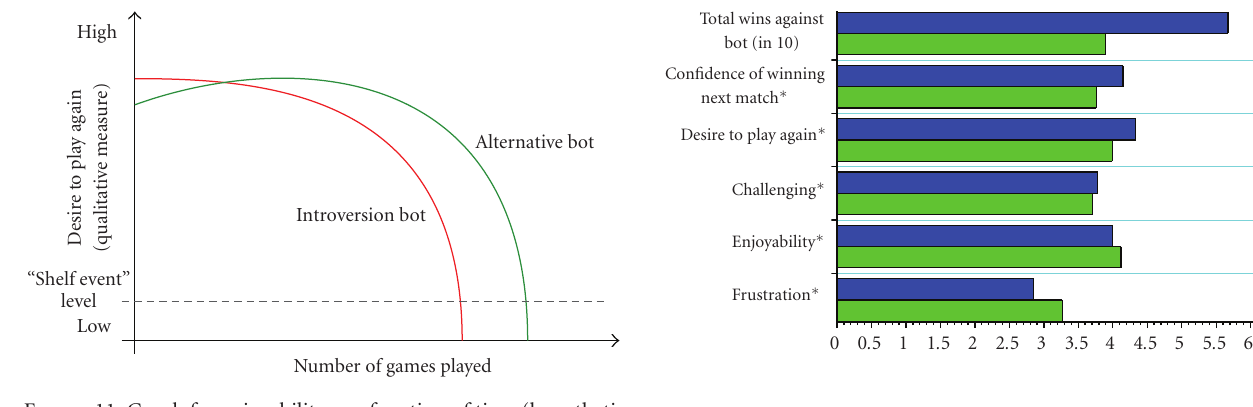
Figure 11: Graph for enjoyability as a function of time (hypotheti- cal).